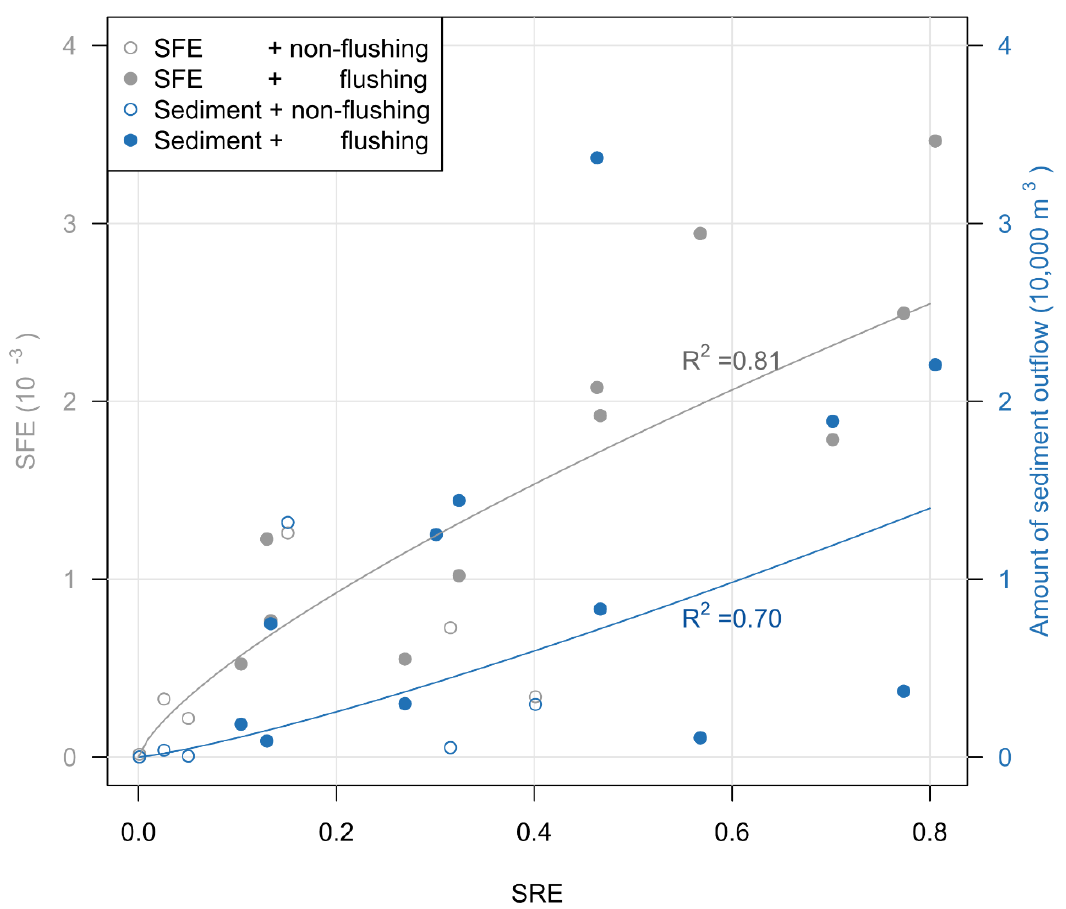
Figure 5. Coe ffi cient of determination for the sediment release e ffi ciency (SRE) to both the sediment Figure 5. Coefficient of determination for the sediment release efficiency (SRE) to both the sediment flushing e ffi ciency (SFE) and sediment flushing efficiency (SFE) and sediment outflow.